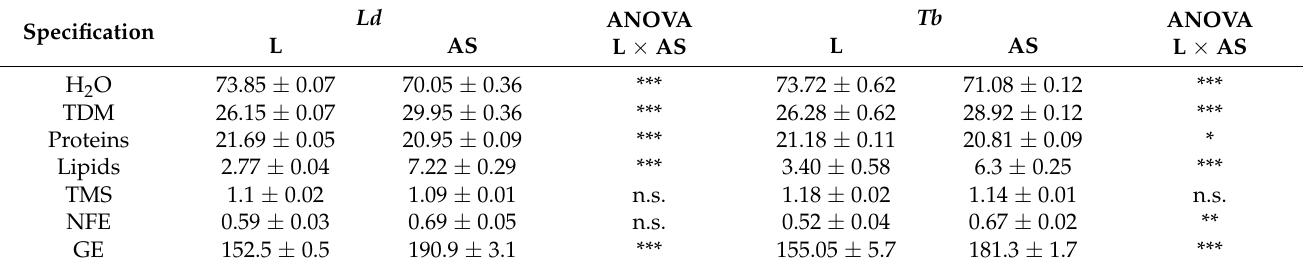
Table 1. Chemical quality indicators (%) of Longissimus dorsi and Triceps brachii muscles from different age categories of sheep ( Karakul